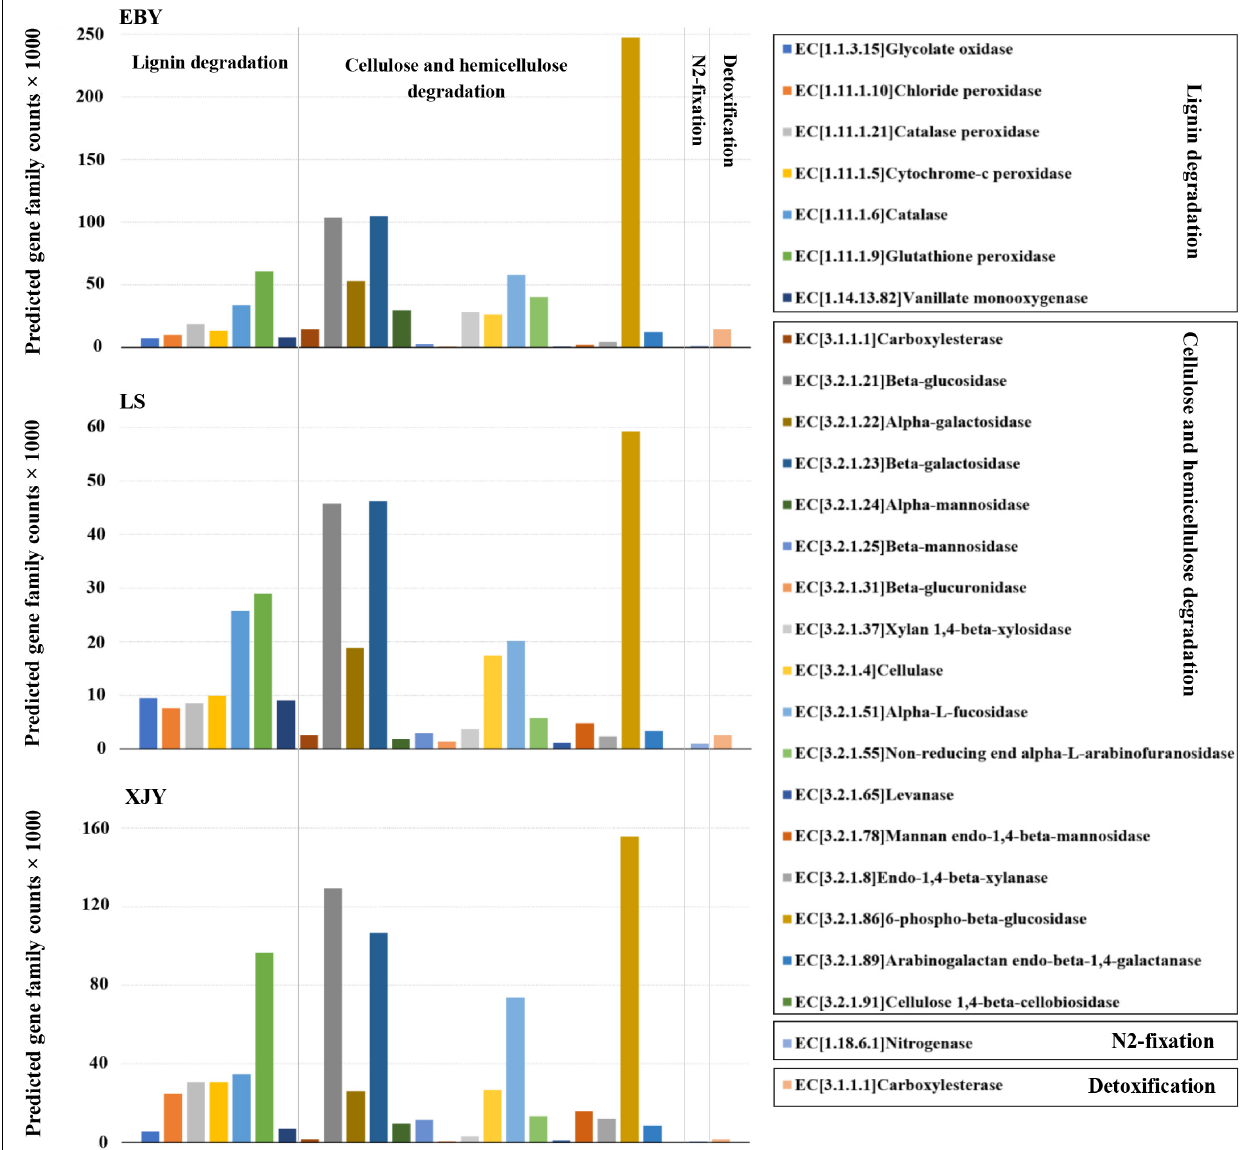
FIGURE 7 | Predicted bacterial community functions in the A. glabripennis larval gut following feeding on different host tree species. The total number of predicted gene family counts is shown. EBY, Populus gansuensis ; LS, Salix babylonica ; XJY, Populus alba var. pyramidalis